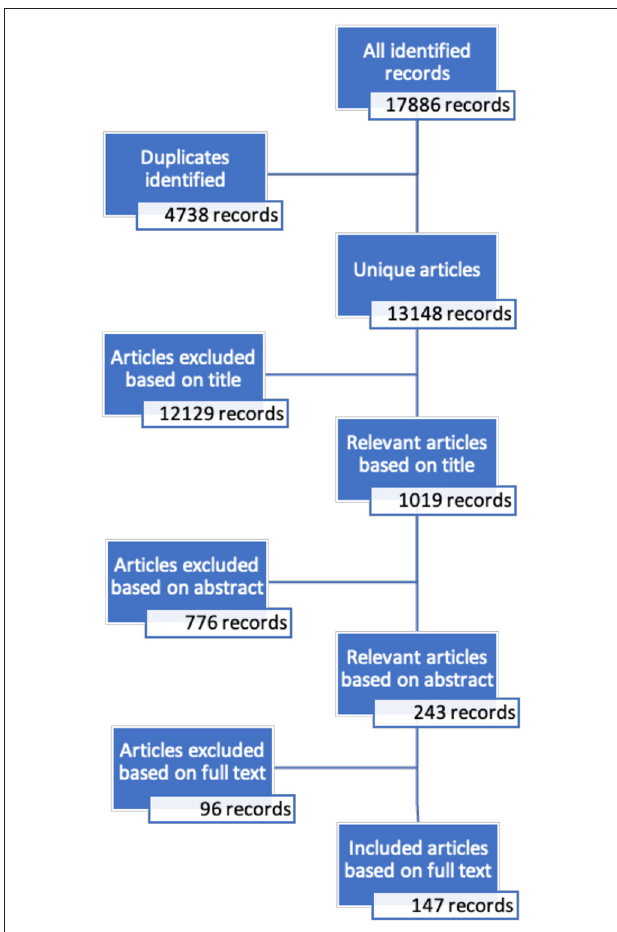
FIGURE 1 | Screening